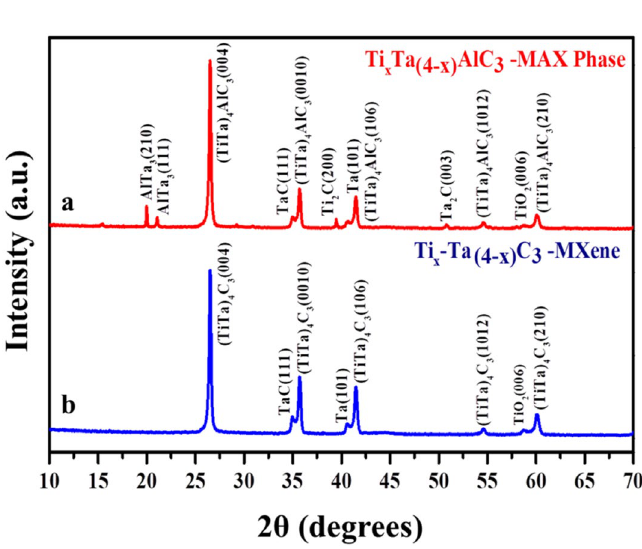
Figure 3. X-Ray Diffraction pattern of the synthesized bi-metallic ( a ) Ti x Ta (4–x) AlC 3 MAX phase, red color; and ( b ) Ti x Ta (4−x) C 3 MXene, blue